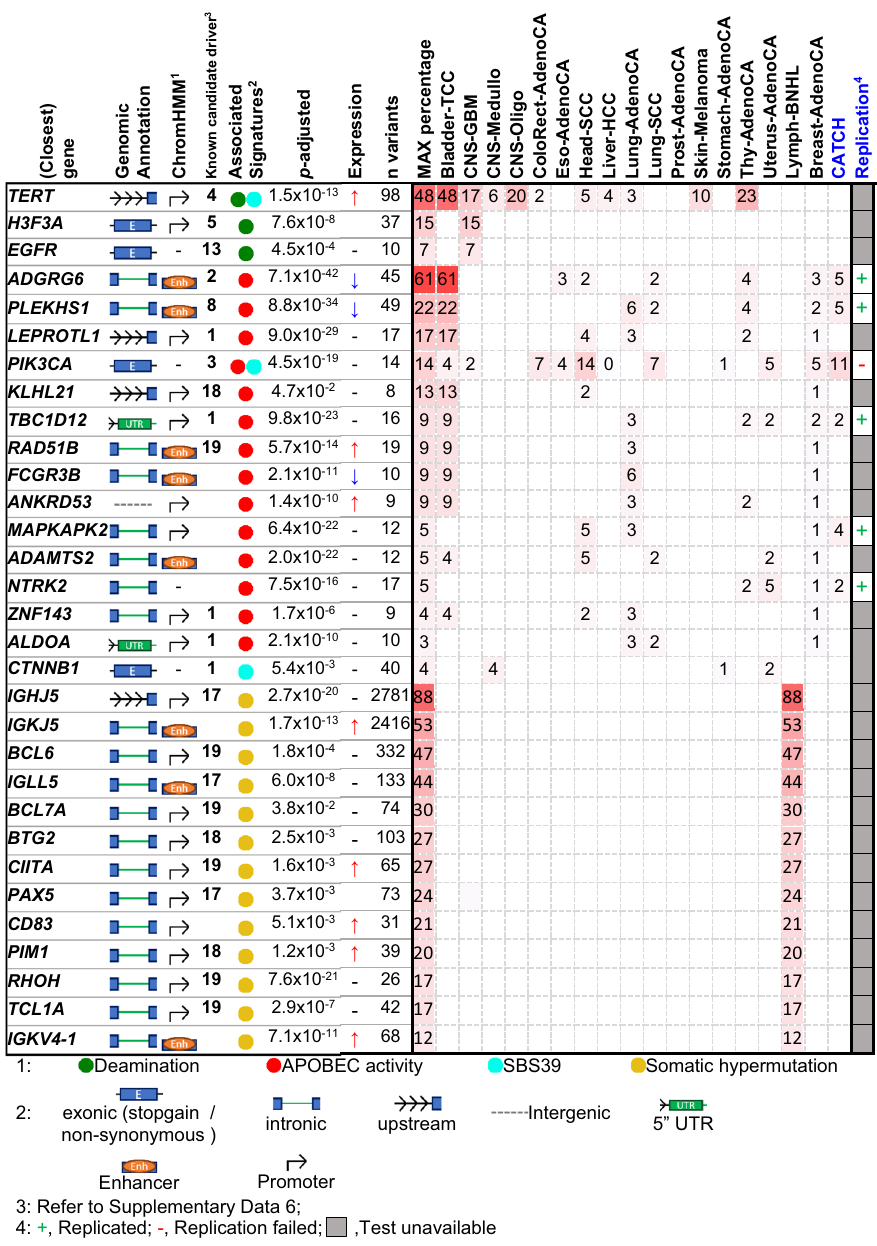
Fig. 2 A summary of putative driver hotspots from COSMIC SBS mutational signatures V3. Hotspots from six driver-associated mutational signatures were included, signatures are classi fi ed into 4 categories: Deamination (SBS1), APOBEC (SBS2/SBS13), somatic hypermutation (SBS9, SBS84), and signature SBS39. Hotspots were annotated by the nearest gene, by their expression impact, by their epigenetic impact from ChromHMM, and by their status as known drivers. The p values indicate the signi fi cance level calculated by sigDriver of the corresponding hotspot after multiple testing correction. Occurrence across entities were summarized in percentages on the heatmap section of the table. The replication cohort designated CATCH comprises metastatic breast cancer samples (blue); the replication status is provided in the respective column. Source data are provided as a Source Data fi